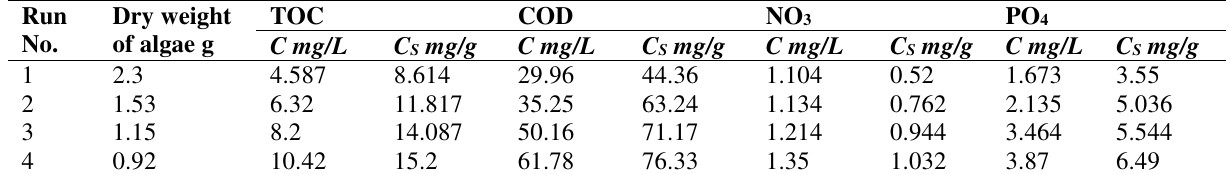
Equilibrium concentrations in the wastewater and on the microalgae for pollutants.